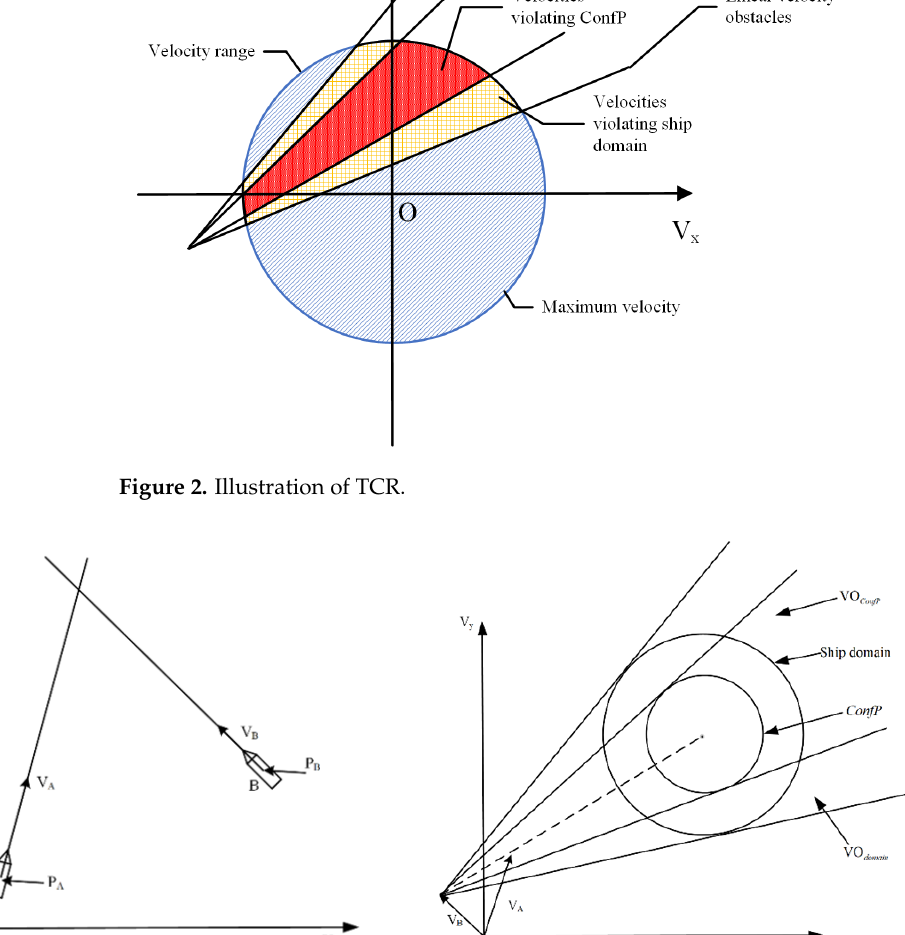
Figure 3. Spatial-temporal relationship between encountered